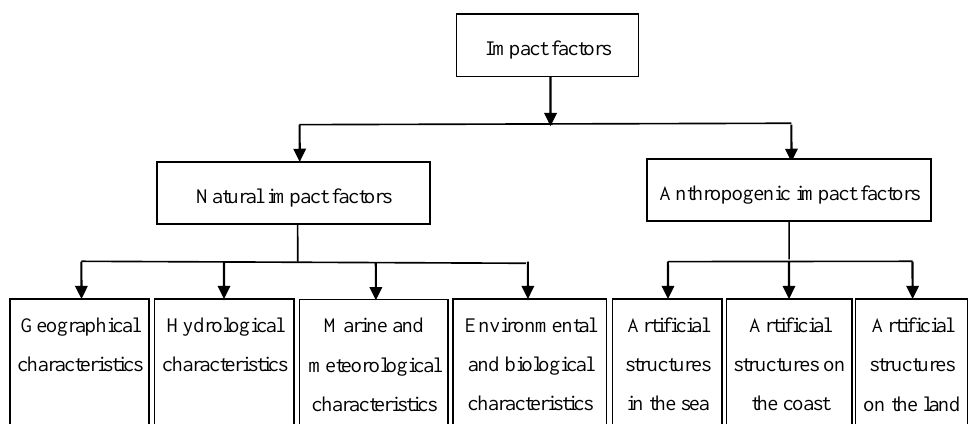
Figure 5. Impact factors of the coastal buffer zone [8].